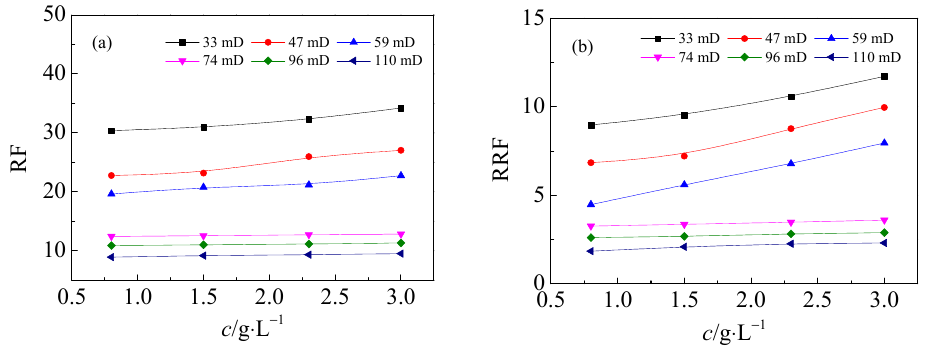
Energies 2022 , 15 , x FOR PEER REVIEW 11 of 19